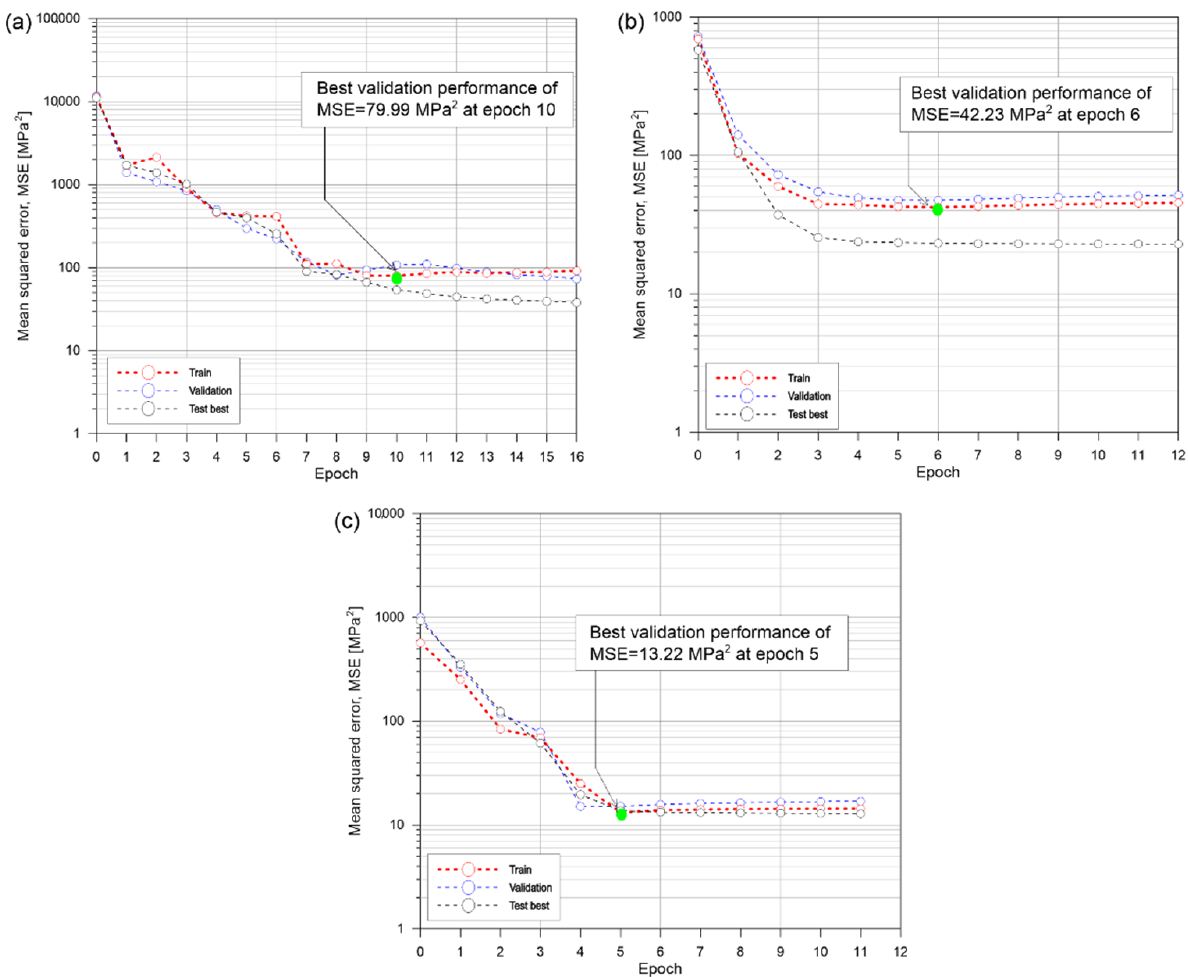
Figure 10. Sample parameter optimization using LM algorithm training: ( a ) 2 parameters, ( b ) 3 parameters and ( c ) 5 parameters.